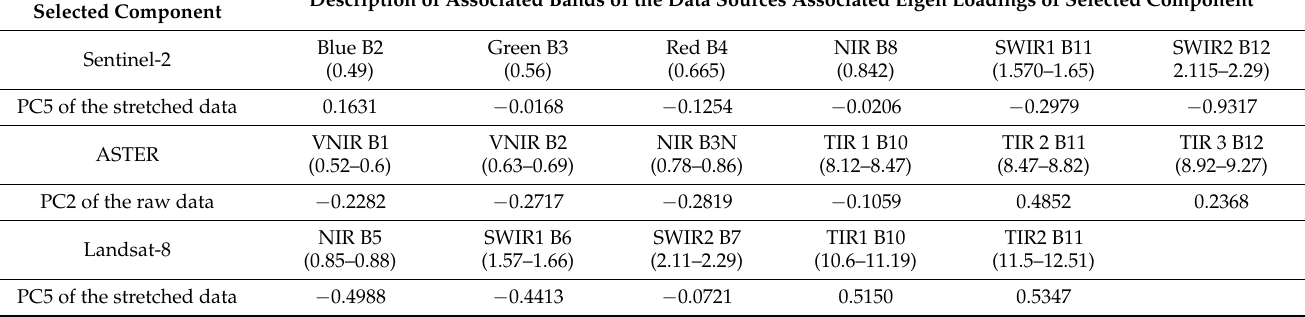
Table 6. Eigenvalues of the selected band ranges/center (in µ m) of different data sources and components in Malakand region. Data Sources Selected Component